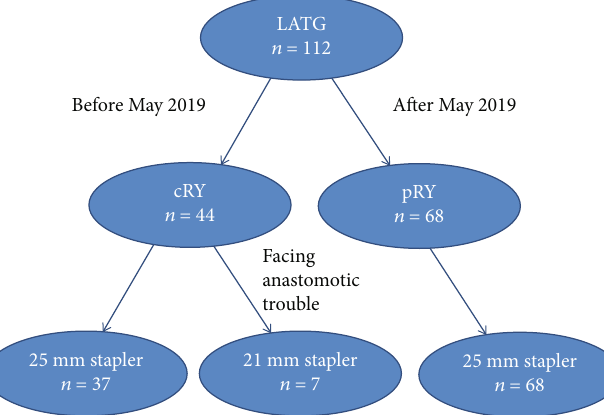
Figure 1: Flowchart of the